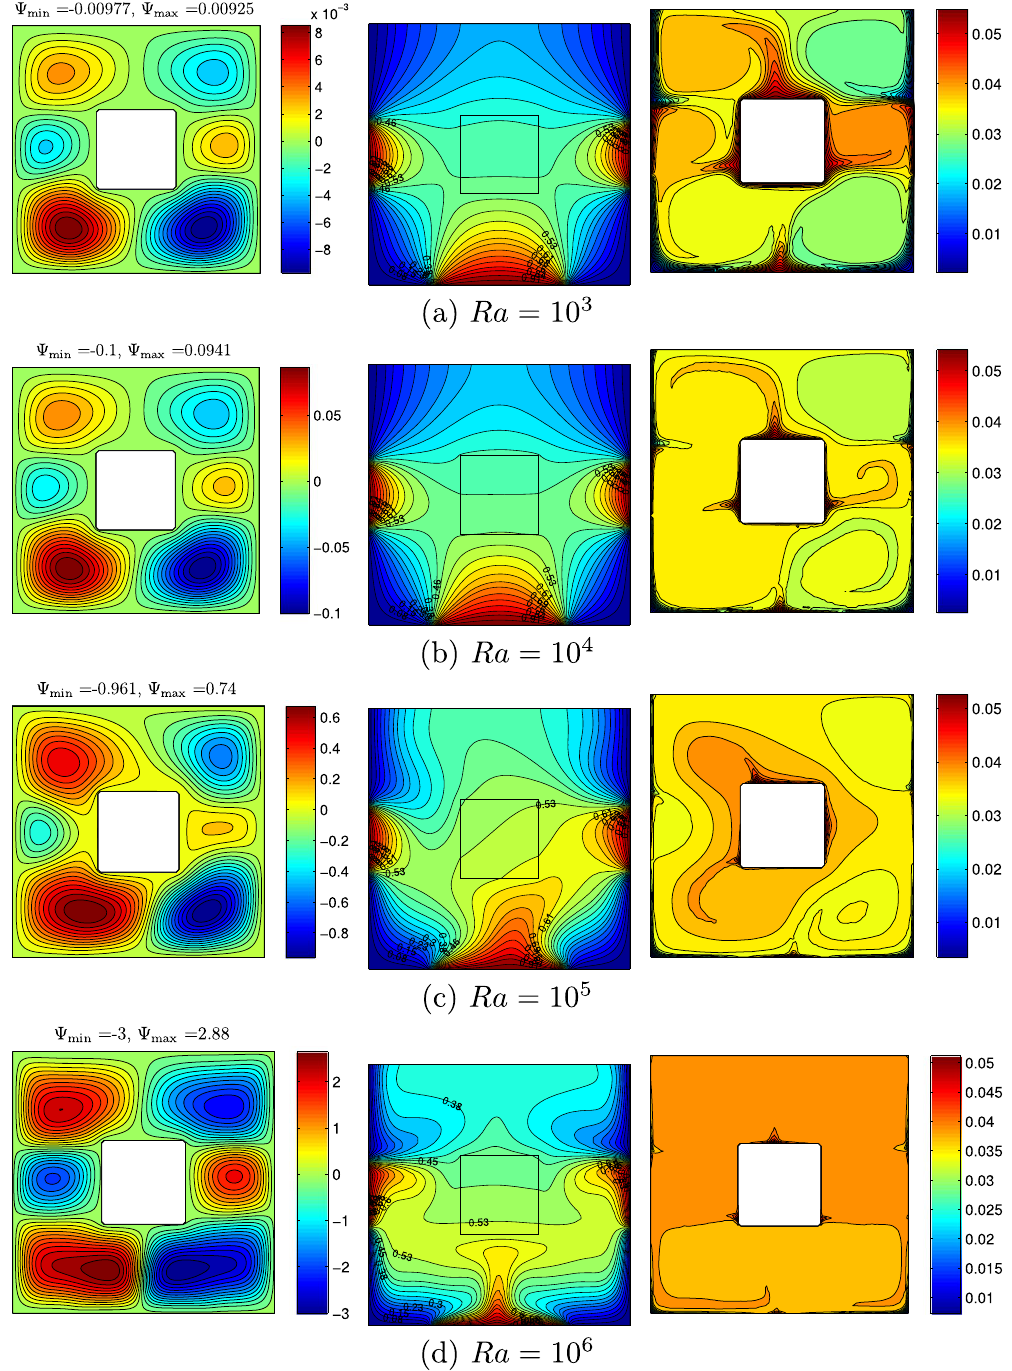
Figure 7. Variation of the streamlines (left), isotherms (middle), and nanoparticle distribution (right) evolution by Rayleigh number ( Ra ) for φ = 0.02, Ha = 15, k w = 0.76 and D =